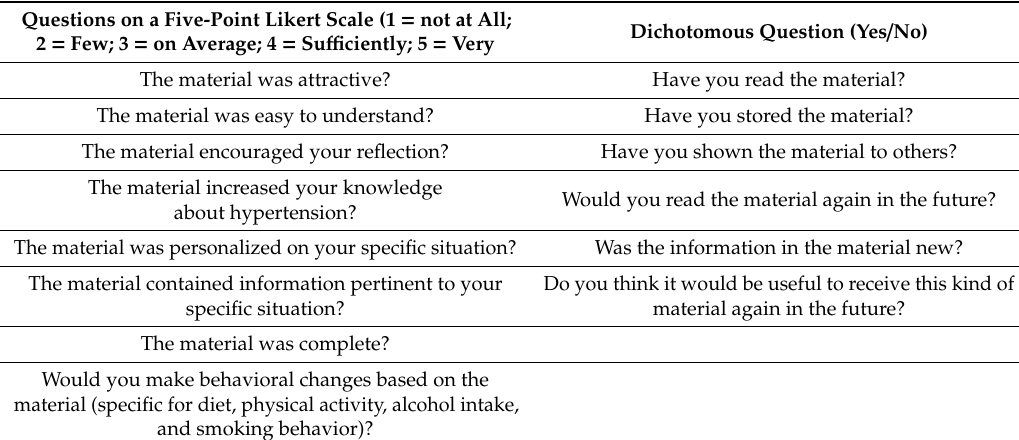
Table 3. Telephone survey to collect patients’ judgments after the delivery of the material. Questions on a Five-Point Likert Scale (1 = not at